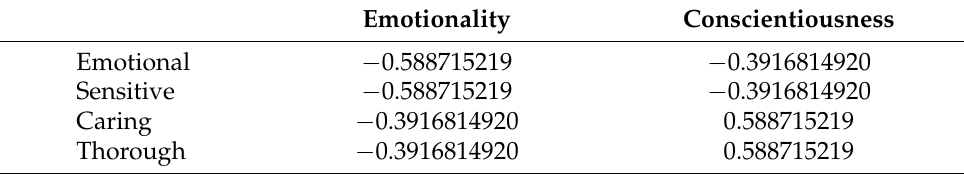
Table 7. Loading matrix B with the TuckerALS algorithm for behavioral level data.